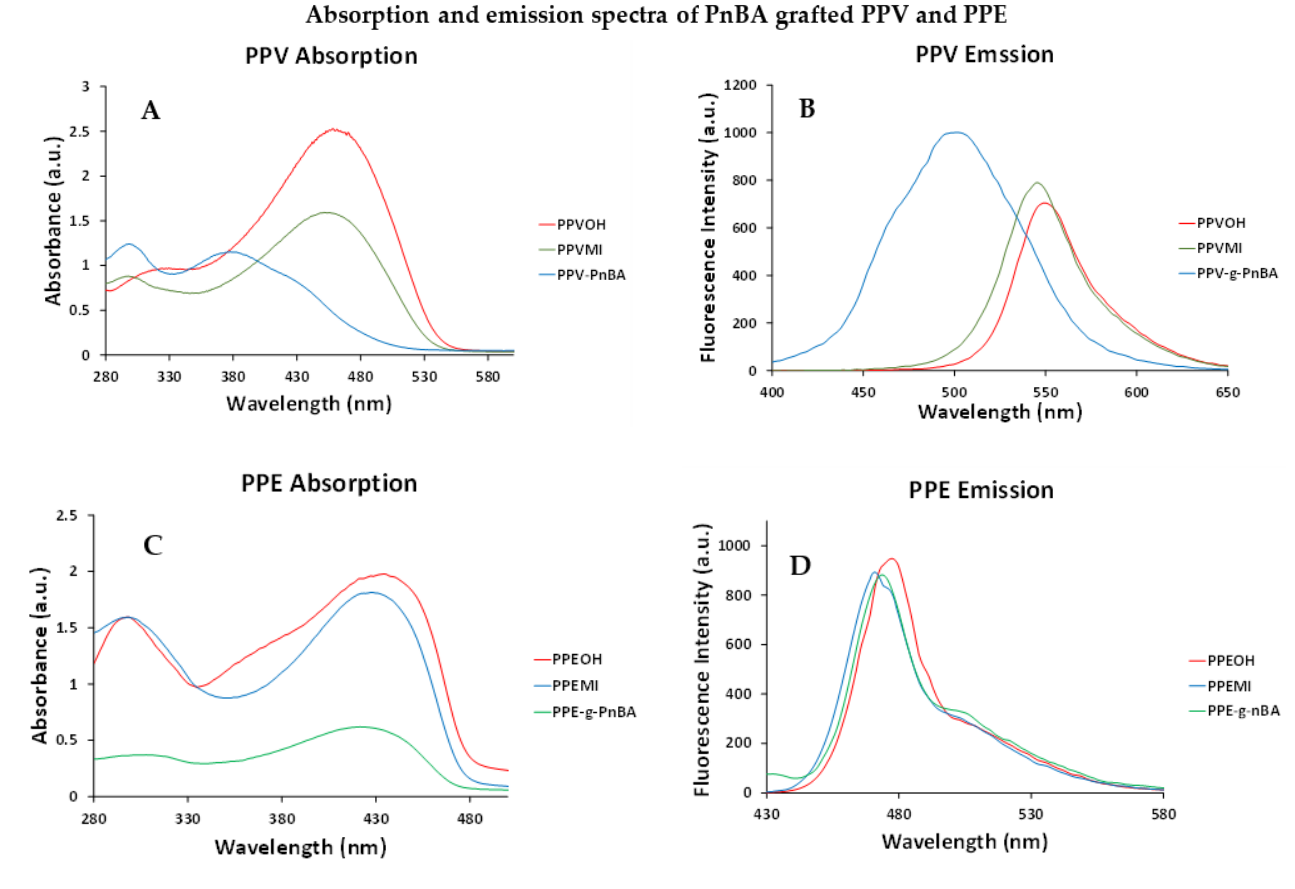
Figure 3. Absorption and emission spectra for PPVOH , PPVMI and PPV- g -PnBA in DMF ( A , B ) and spectra for PPEOH , PPEMI and PPE- g -PnBA in DMF ( C , D ).